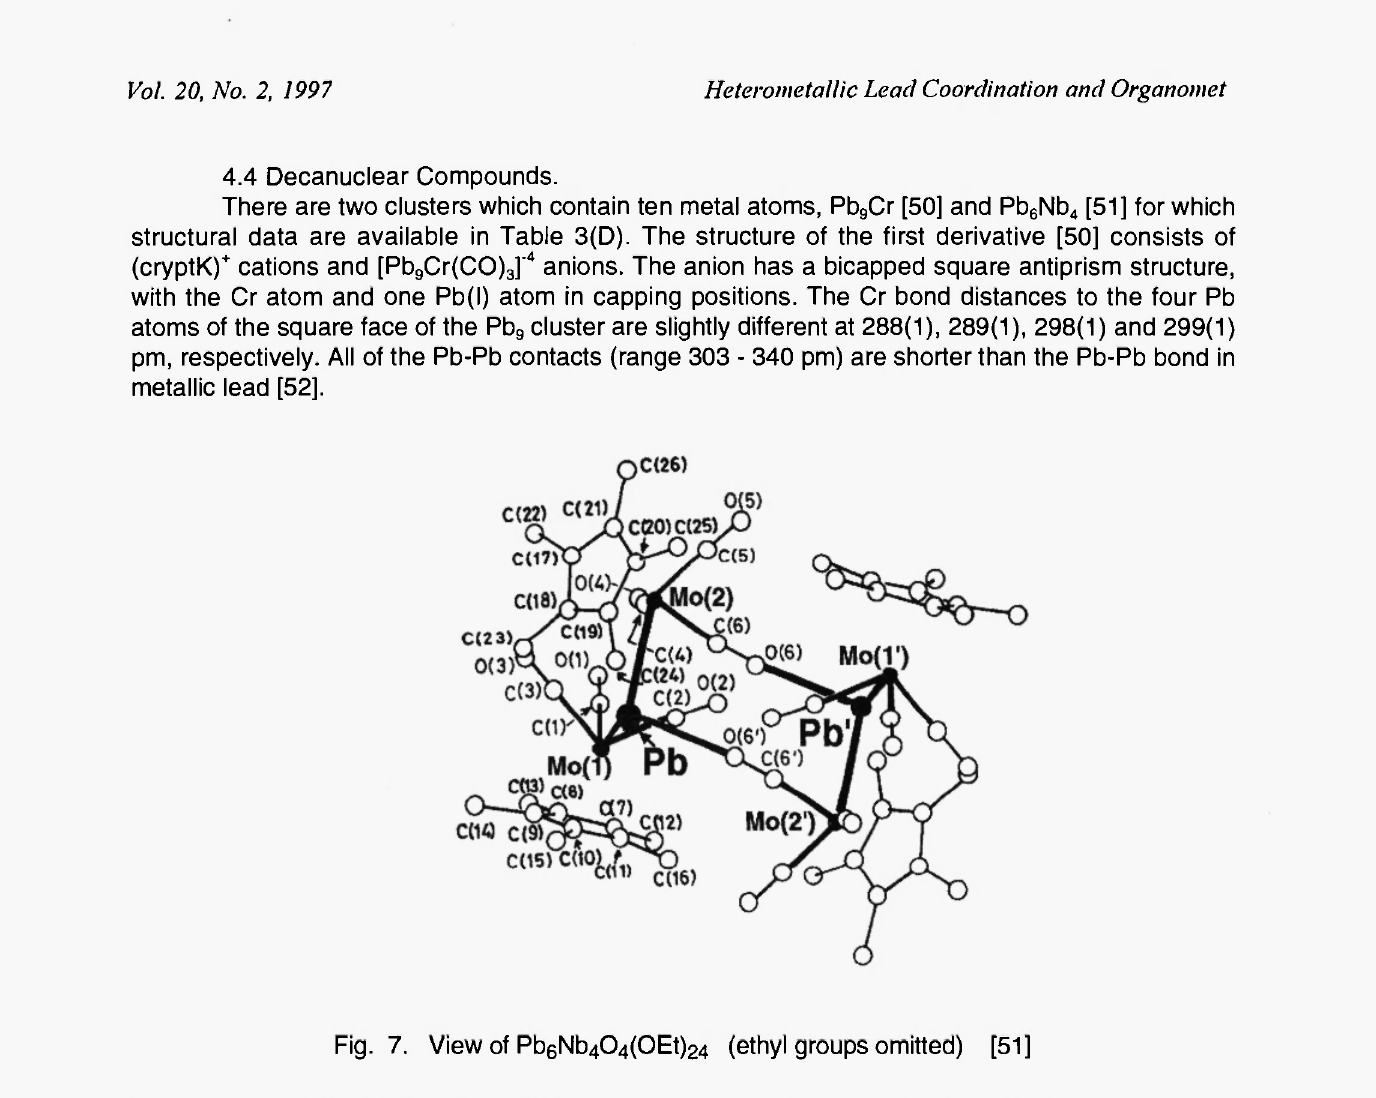
Fig. 7. View of Pb 6 Nb 4 0 4 (0Et)24 (ethyl groups omitted)